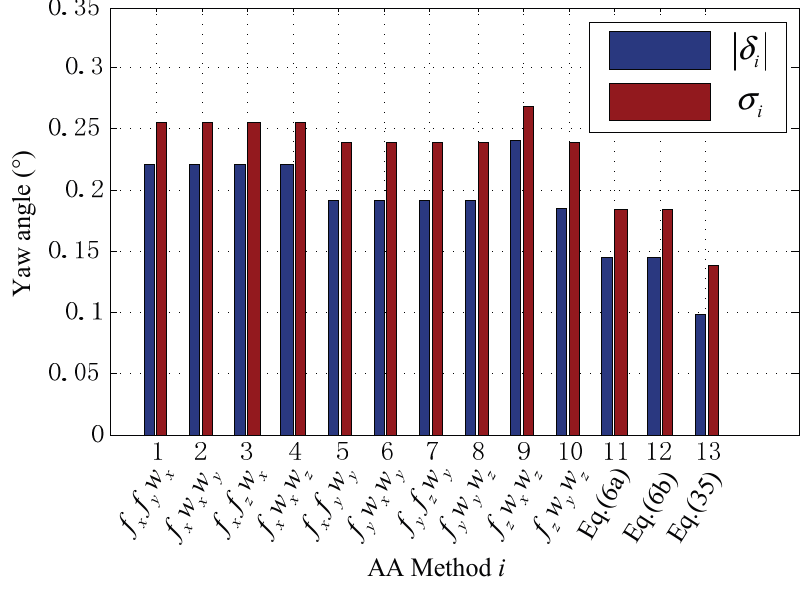
Figure 11. The errors of the yaw angle obtained using AA